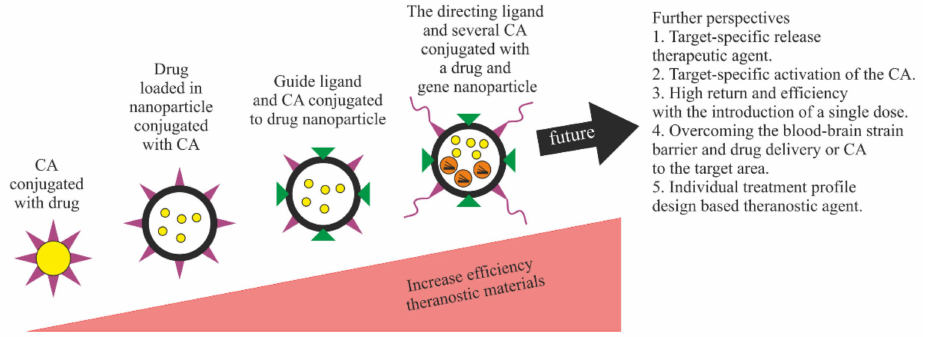
Figure 16. Schematic illustration of advances in the field of nanotheranostics. CA, contrast